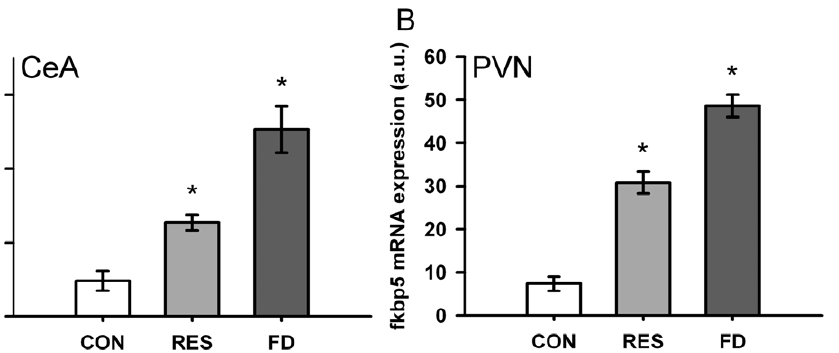
Figure 3. Regulation of fkbp5 mRNA in the central amygdala and the hypothalamic PVN following restrained stress or food deprivation. ( A ) In the central amygdala, fkbp5 mRNA was upregulated 4 h after restrained stress and even more pronounced after 24 h of food deprivation. ( B ) In the hypothalamic PVN, a similar regulation was found. CON = control, RES = restrained stress, FD = food deprivation, CeA = central amygdala, PVN = paraventricular nucleus. Data are given in mean 6 SEM. * different to control p ,